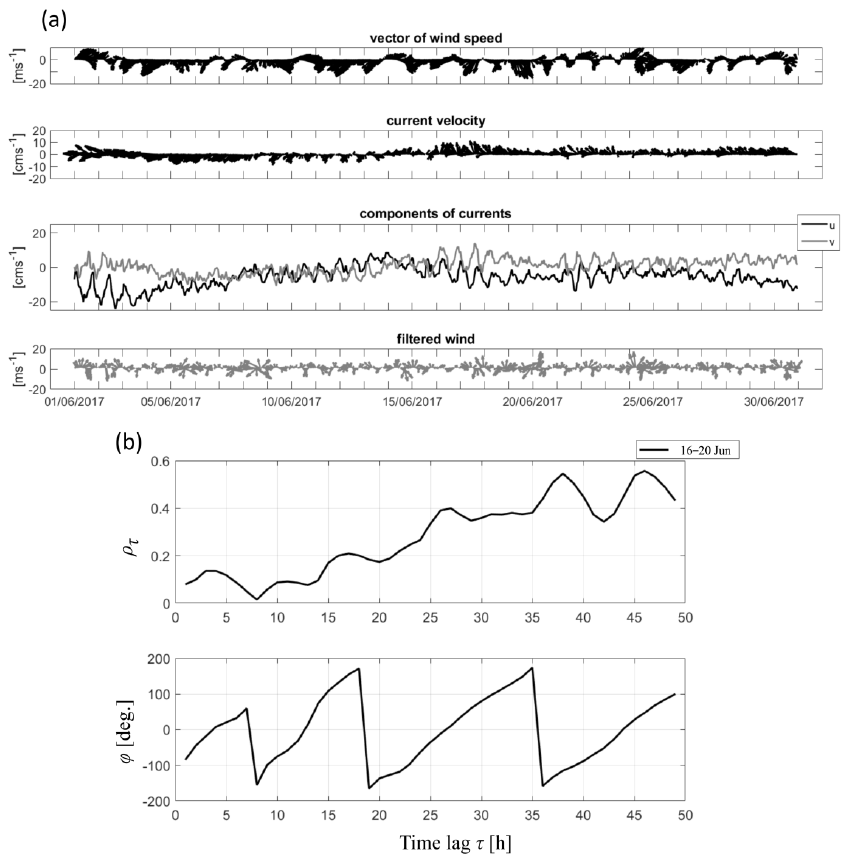
Figure 10. ( a ) Top—wind speed U ( t ) vector plot from the ERA-5 meteorological reanalysis data. The second plot from the top is the current velocity u ( t ) at 100 m at ABS No. 1 in June 2017, and the third plot from the top shows the u - and v -components of the current velocity. Bottom—wind speed after band-pass filtering for 22–26 h. ( b ) Top—lagged correlations ρ τ between the wind and current vectors for 16–20 June 2017, bottom—the angle ϕ of rotation of the current velocity vector relative to the wind velocity vector.